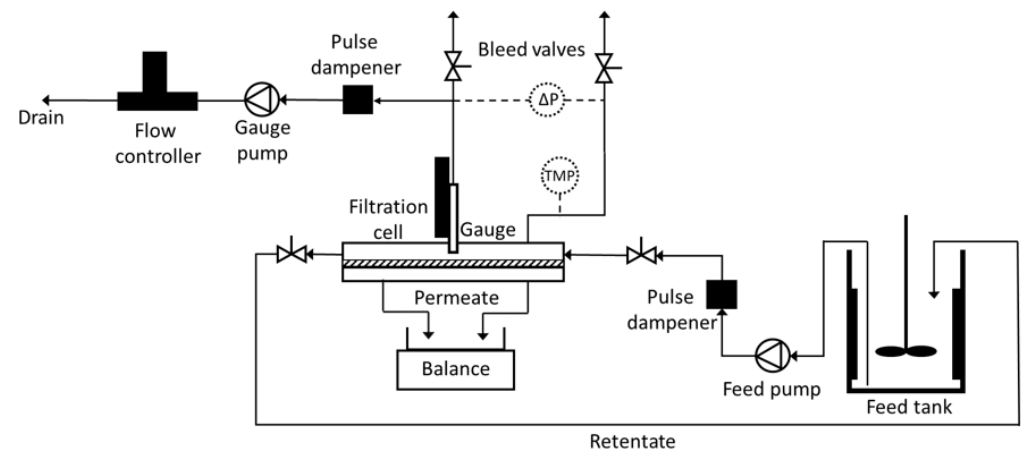
Figure 1. Schematic diagram of the fluid dynamic gauging (FDG) cross-flow filtration system.